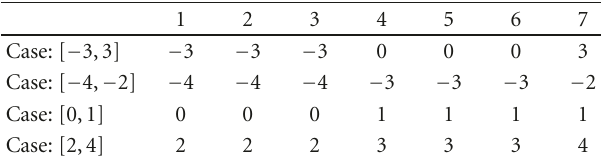
Table 2: Simulation cases with di ff erent SNR(dB) distribution.